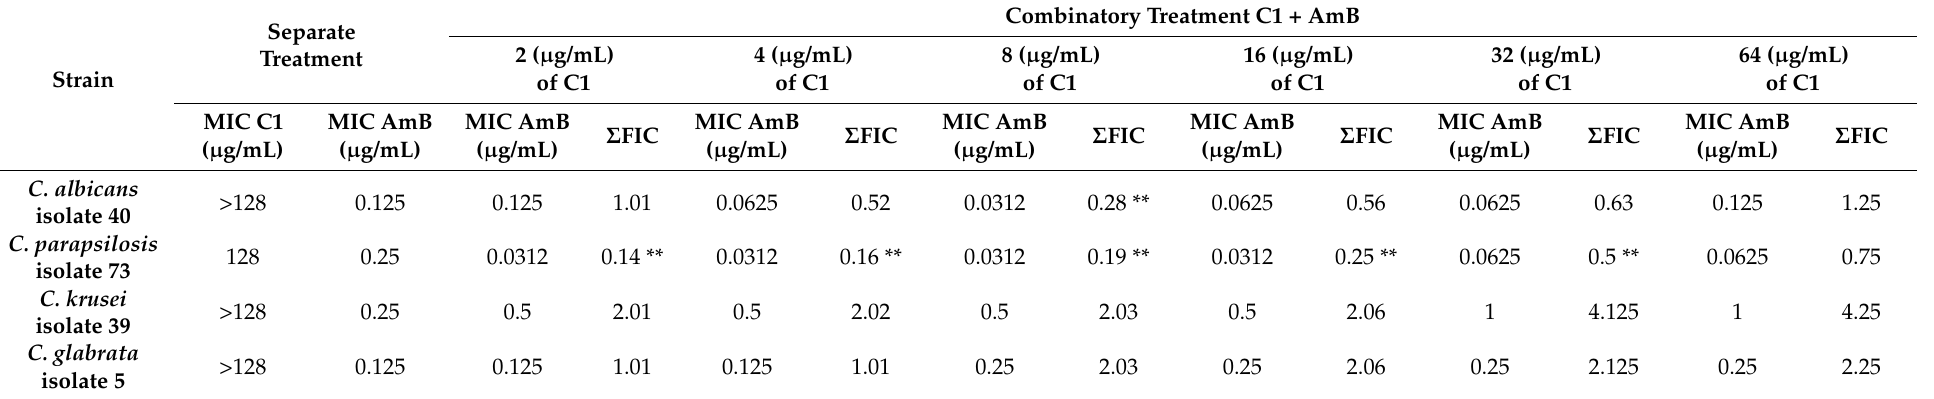
Table 2. Interactions of C1 with AmB against clinical strains in vitro after 48-h incubation. MIC—minimal inhibiting concentration of the compound, ∑ FIC—coefficient, which is the sum of partial concentrations inhibiting the growth of the pathogens. The interactions were determined based on the speci-